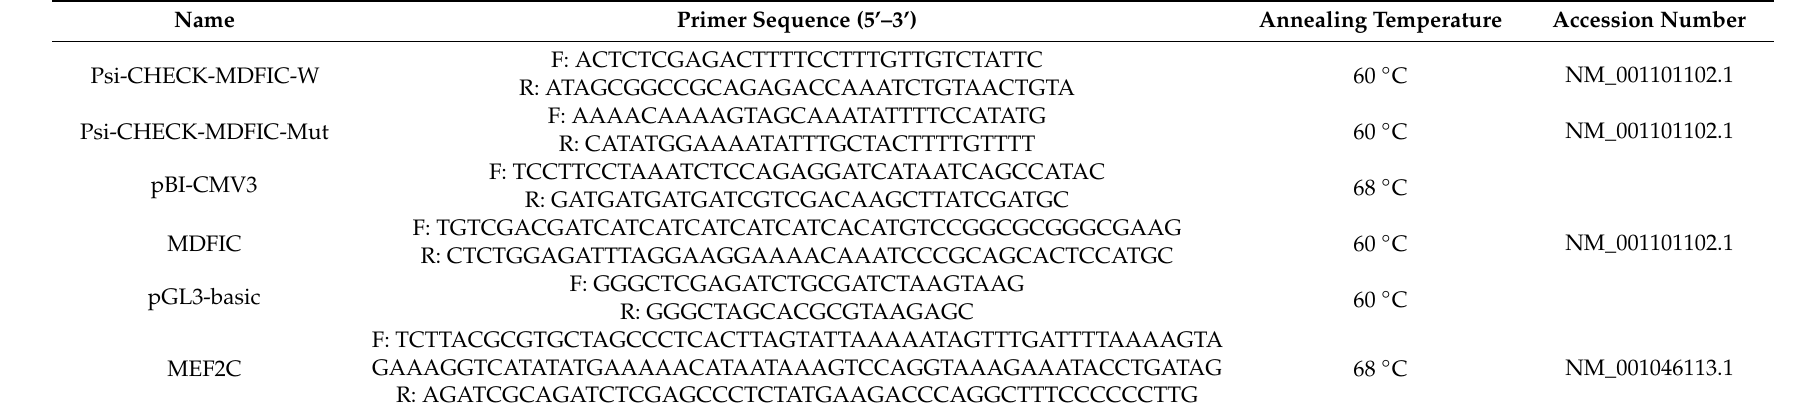
Table 2. Primer sequences designed for vector